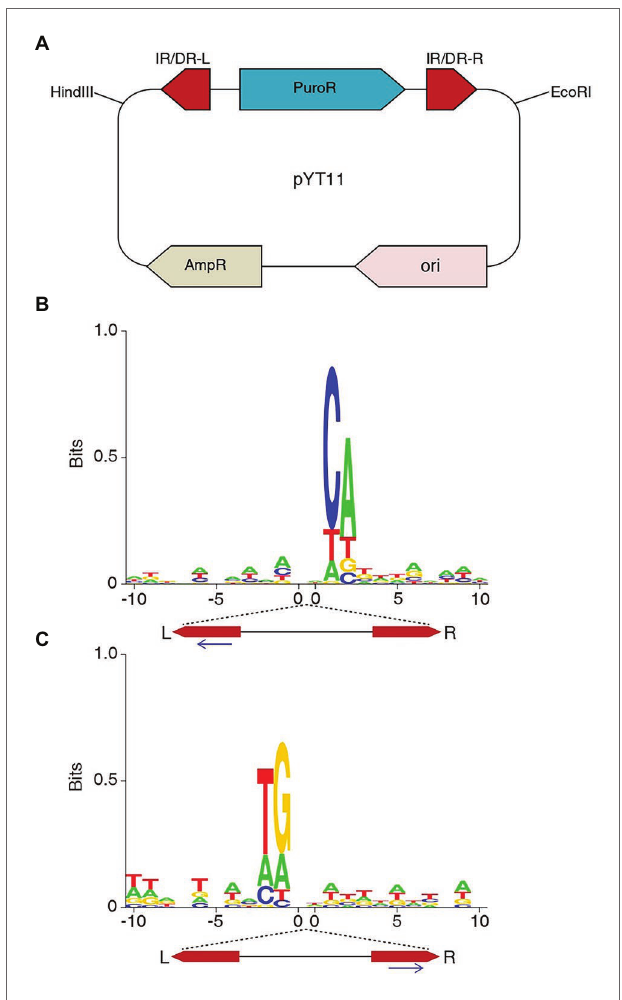
FIGURE 2 | SB transposon integrates at non-TA sites in HEK293T cells. (A) The structure of plasmid pYT11, puromycin resistance gene flanked by the IR/DRs of SB. (B) The consensus sequences of the SB non-TA integrations sequenced from the left end. (C) The consensus sequences of the SB non-TA integrations sequenced from the right